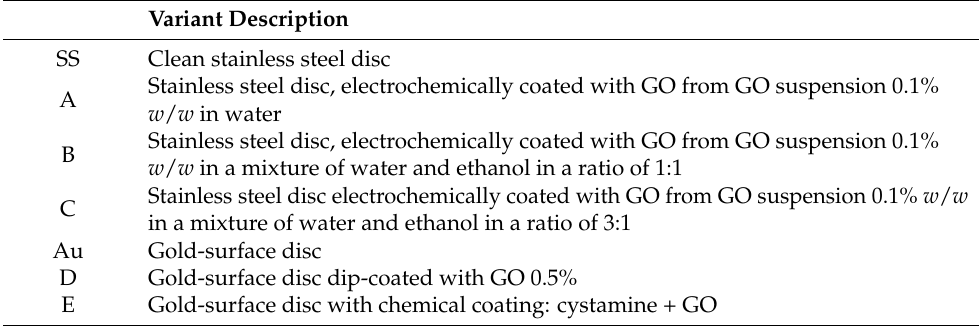
Table 1. A list of symbols representing variants of material.